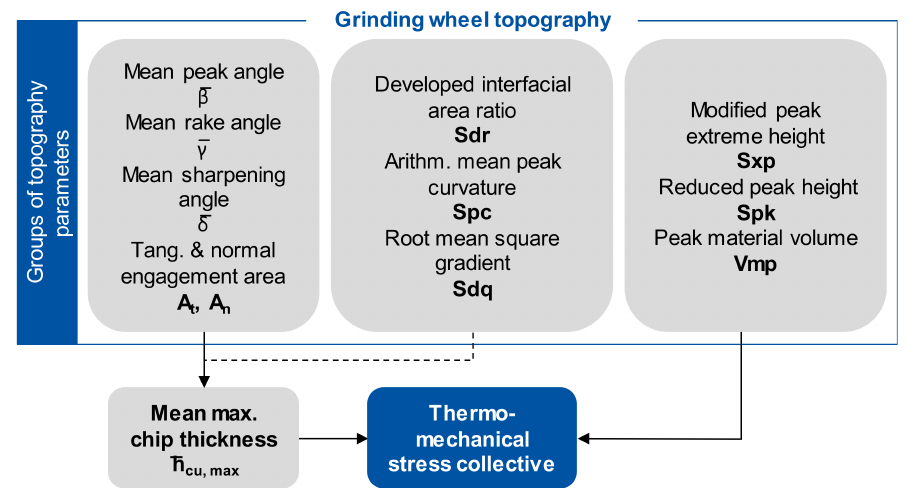
Figure 14. Overview about the topography parameter groups with an influence on the process